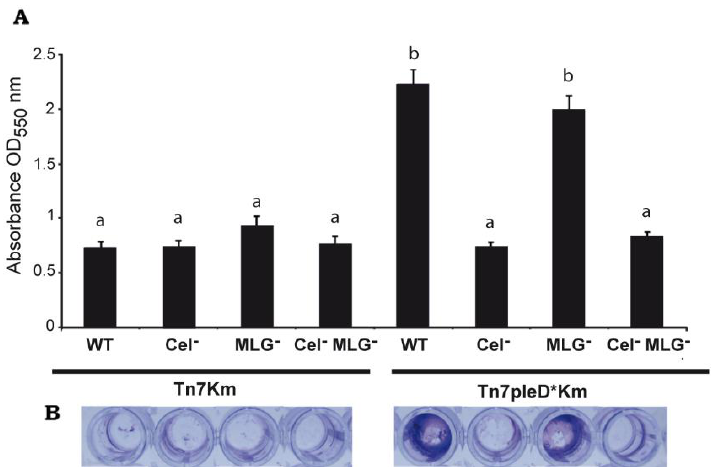
Figure 4. Role of Cellulose and MLG in biofilm formation by R. etli CFN42 . ( A ) Biofilm formation by single mutants in celAB cellulose genes (Cel − ), in bgsA (MLG − ), the double mutant (Cel − MLG − ) and their respective parental strains (WT) with or without pleD* quantified after static growth, 72 h in MM in a 96-well plate at 28 °C, by crystal violet (CV) staining and represented as the means of eight different wells for each strain ± standard deviation of three independent experiments. Similar growth of all strains was confirmed by measuring OD 600 before CV staining. ( B ) Representative pictures of biofilms adhered to the wells of the polystyrene plates, stained with CV, before resuspension with ethanol. Different letters over the bars indicate statistical significant differences with a p < 0.05.